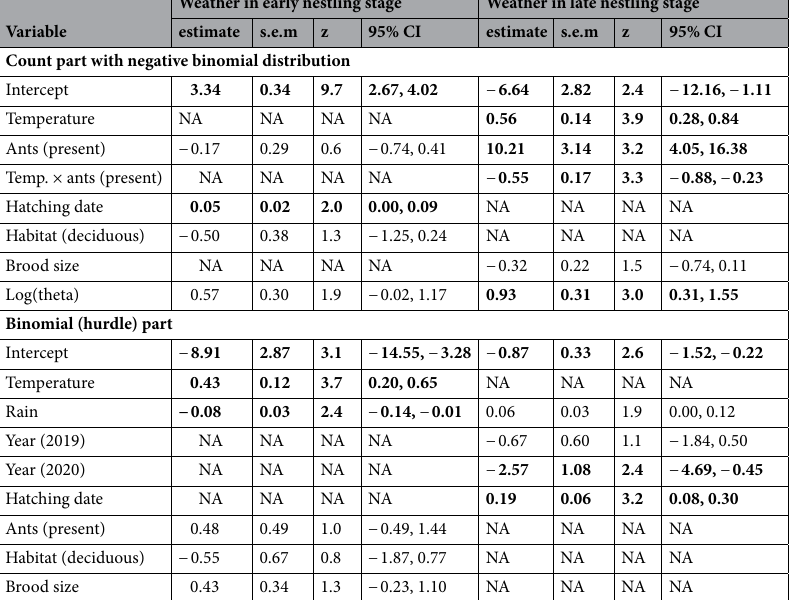
feather length and mean ambient temperature in the same period, as the temperature was dropped from the top linear mixed effects models with ΔAICc < 2 (Table 3). The body mass of nestlings changed little in relation to ambient temperatures and rainfall during the period from when they were 5 days old and until they were meas- ured (both weather variables were insignificant in averaged models; Tables 5, 6).